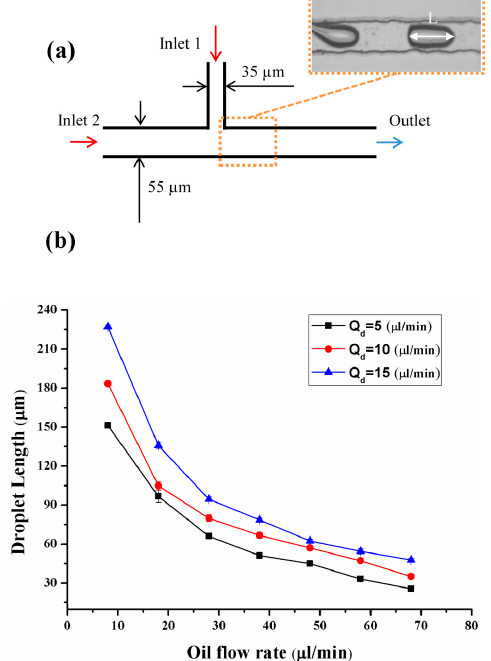
Figure 6. ( a ) The design of the “T-junction” microdevice used for generating emulsions. All channels have a depth of 50 µm. The inset illustrates the generation of the water-in-oil emulsions in the device. The parameter “L” represents the length of a droplet; ( b ) Relationship between the droplet length and flow rate of oil and water in the two-dimensional “T-shape” junction microchannel. Q d is a parameter of the dispersed phase (deionized water) flow rates. The curve fits were obtained using experimental data.